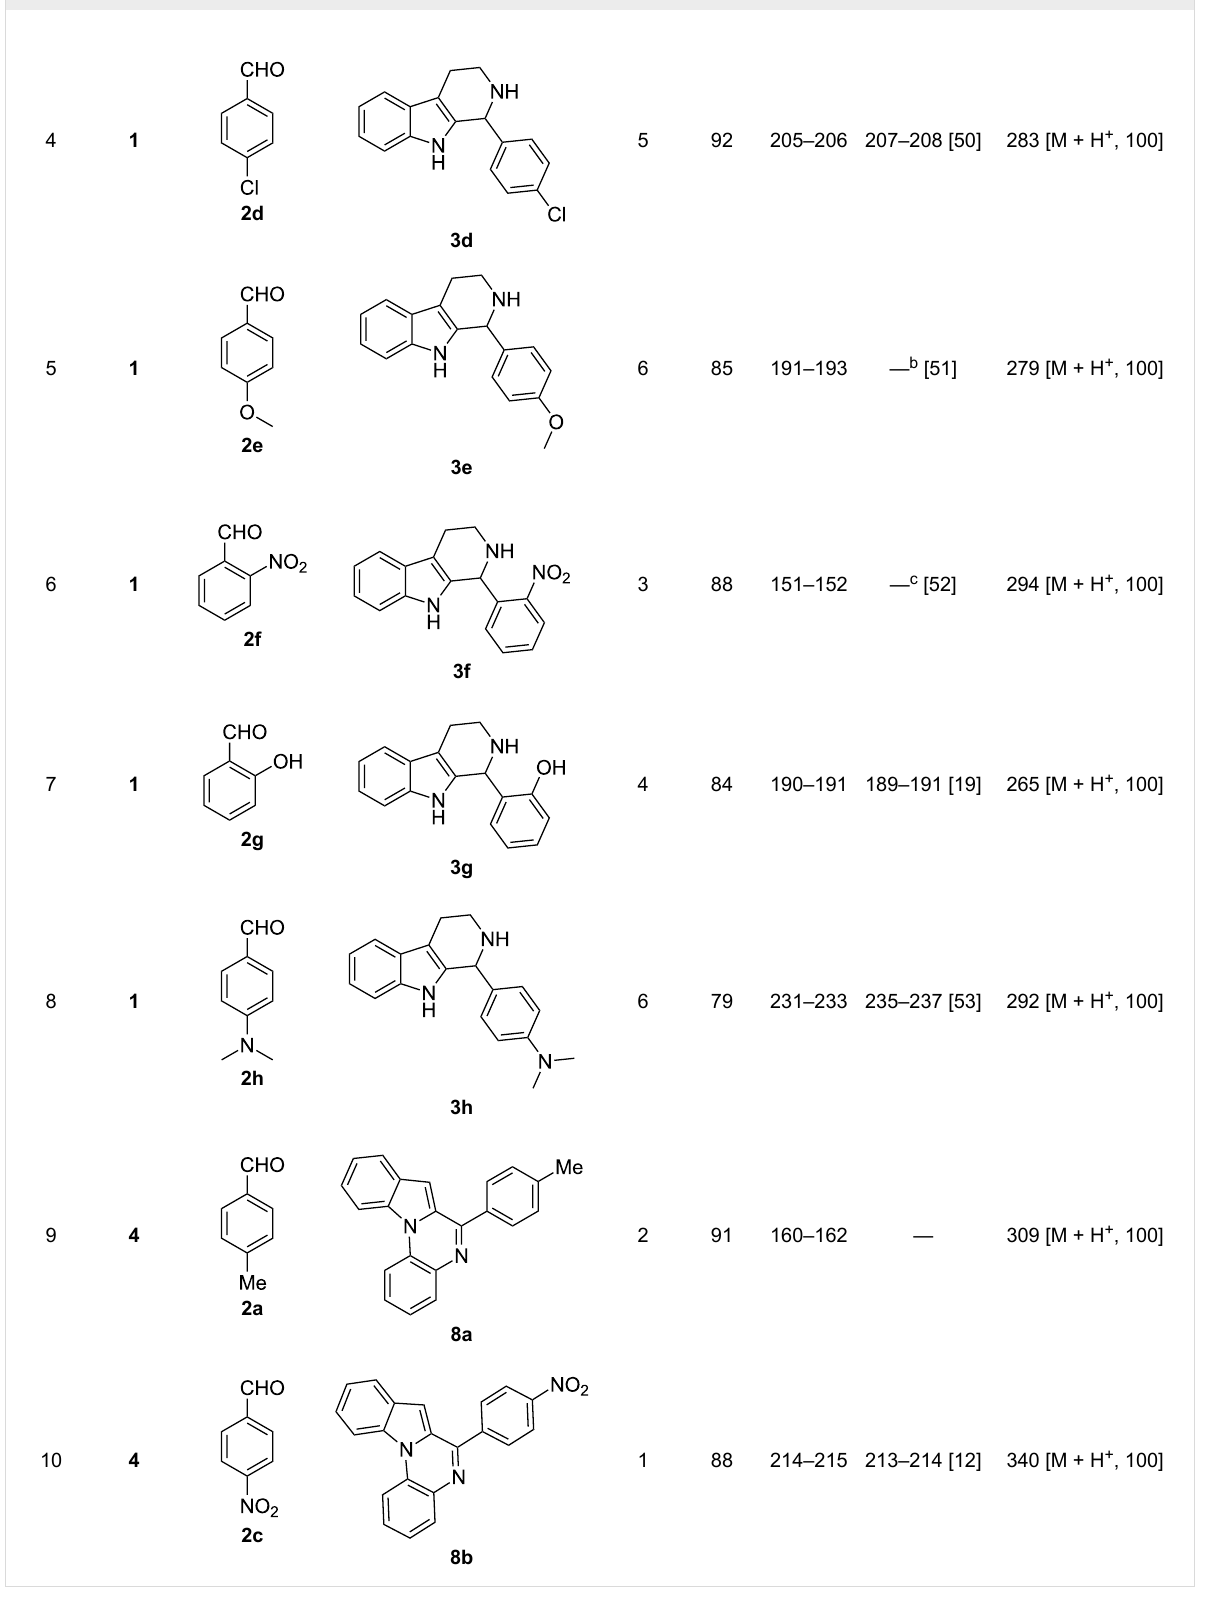
Table 2: Condensation of the Pictet–Spengler substrates 1 and 4 (1 equiv) with aldehyde (1 equiv) in the presence of TCT (20 mol %) in DMSO under a nitrogen atmosphere.